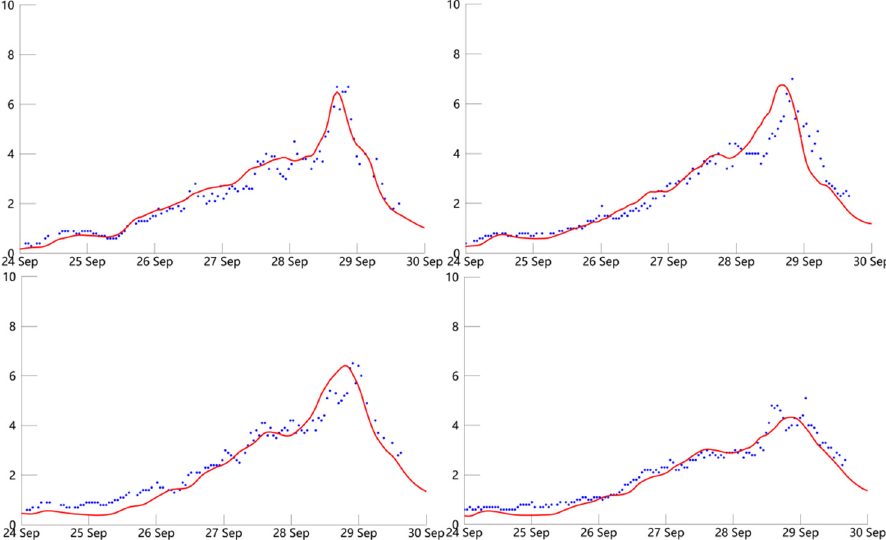
Figure 12. The temporal distributions of signi fi cant wave heights (m) obtained from experiment 1 (red line) and buoy observations (blue dot) during typhoon Dujuan at the locations of four buoys.